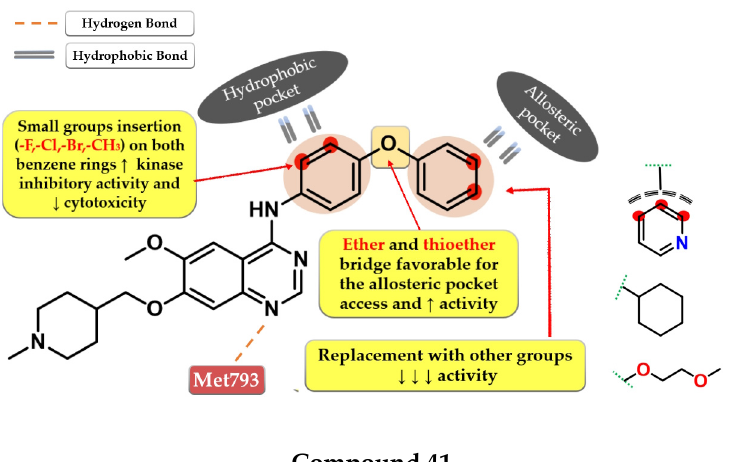
Figure 29. Structure–activity relationship and molecular docking of compound 41 in the molecular model of EGFR del19/T790M/C797S ATP-binding domain, build using Maestro (PDB ID 1XKK used as a template) [101], as reported by Dou et al. [211].